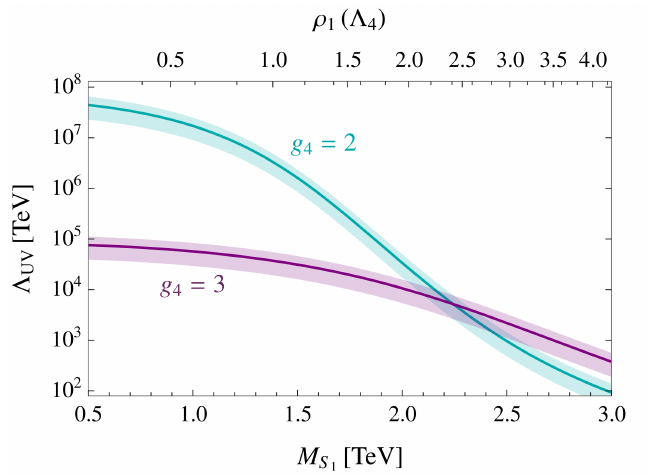
Figure 2 . Dependence of the cut-off scale of the 4321 model as a function of the mass of the S 1 radial. The mass of S is mostly governed by the value of ρ 1 The bands corresponds to a 50% variation around the matching scale, set at central value Λ